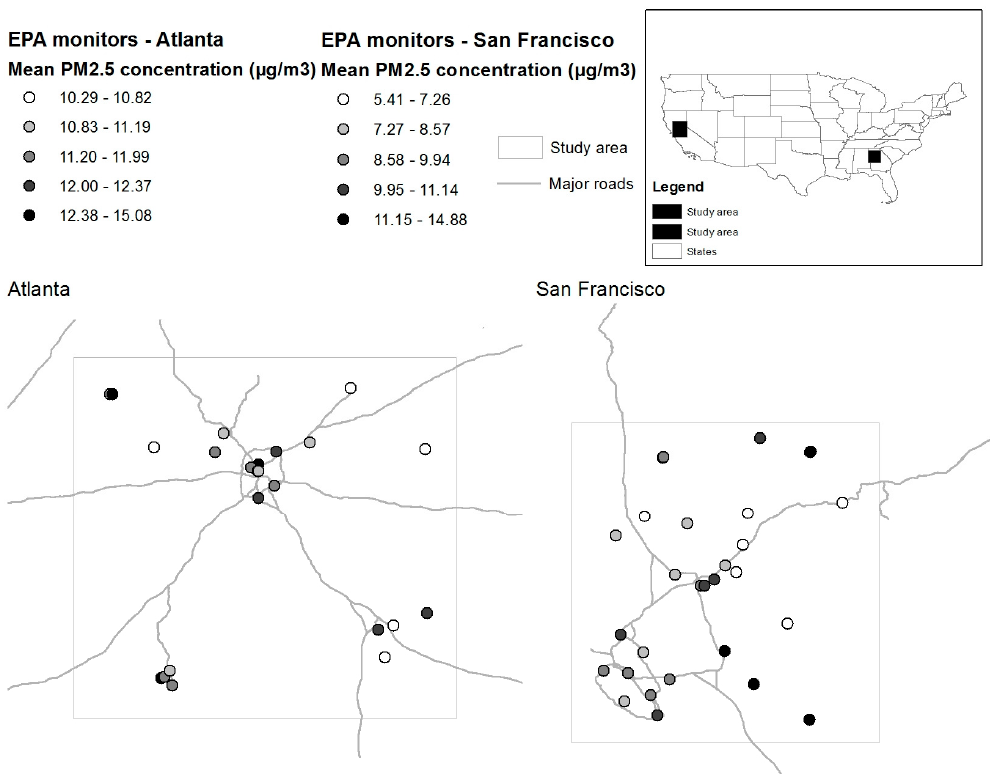
Figure 1. Study site definitions and Environmental Protection Agency (EPA) ground monitor distributions within the two study areas. Mean PM 2.5 concentrations over the study period are displayed for each monitor.